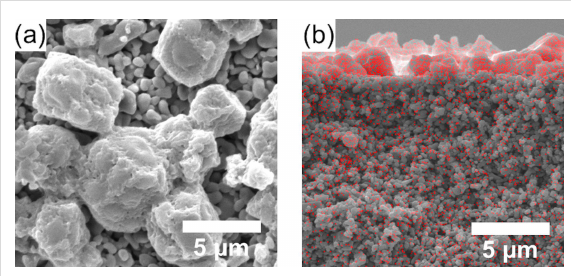
Figure 7: (a) Top-view and (b) cross-sectional SEM images of ZIF-8 membranes fabricated via a counter-diffusion synthesis method (50 mM of 2-methylimidazole at 80 °C for 12